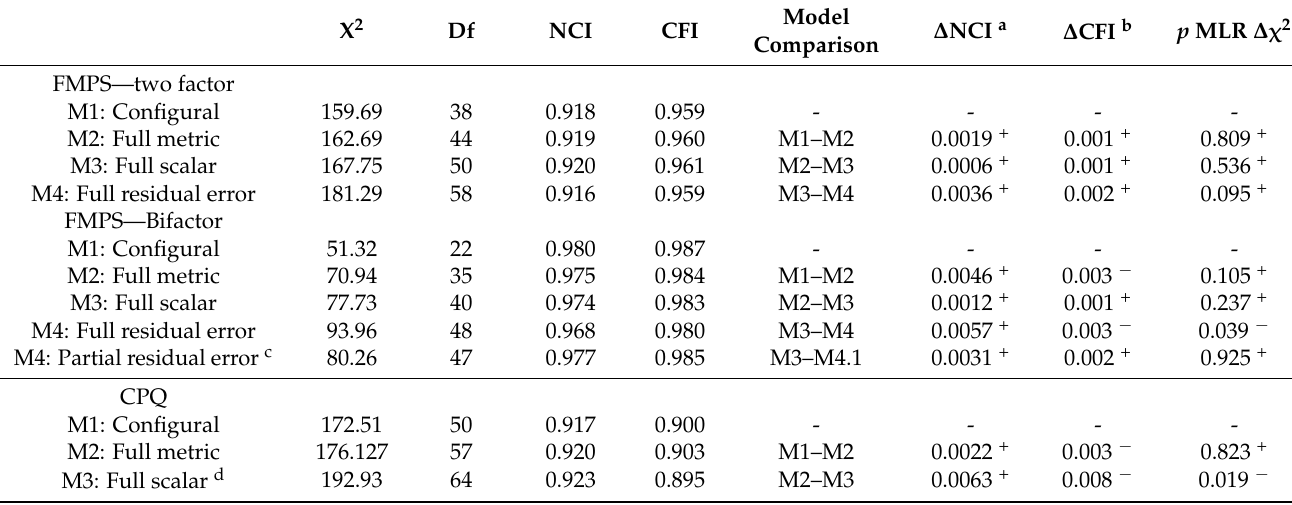
Table 3. Evaluation of measurement invariance in measures of rumination between groups of individuals with and without a history of self-injury.